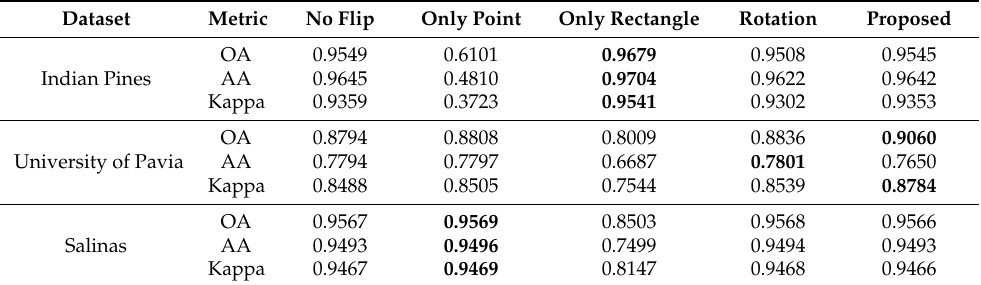
Table 8. Accuracy obtained with different augmentation methods. The best value in a row is bolded.